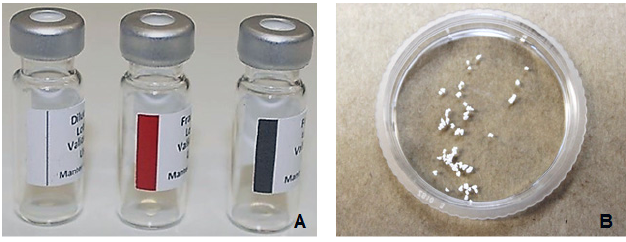
Figure 1. (A) Fibrin biopolymer vials [26]. (B) Presentation of the biphasic calcium phosphate: aspect of the